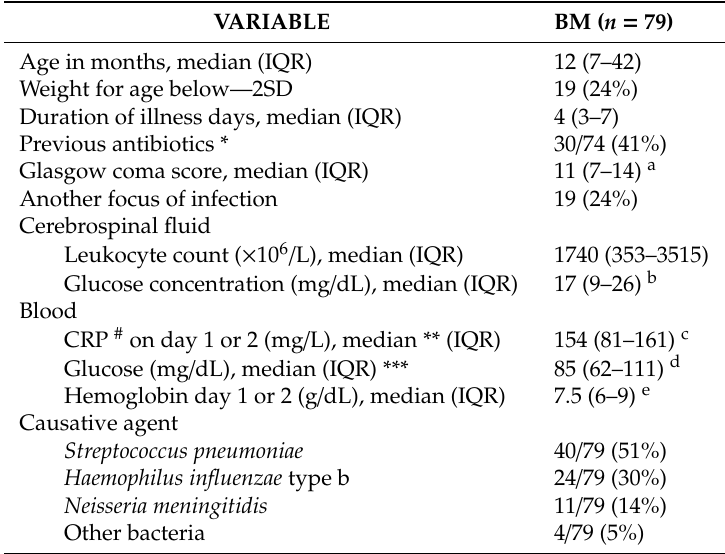
Table 2. Baseline characteristics of bacterial meningitis (BM) patients in Luanda with analyzed admission cerebrospinal fluid (CSF)